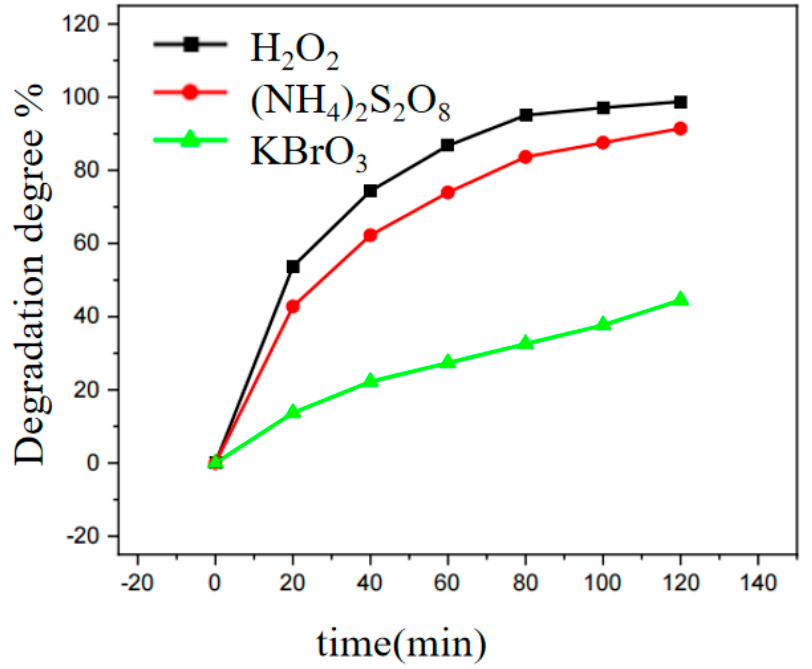
Figure 5. Effect of different electron trapping agents on photocatalytic oxidation of RhB. (Reactor: pH at 4.5, MIL-53(Fe)@CF photocatalytic membrane 150 mg, RhB 1 mg/L, H 2 O 2 1mmol/L). Table 1. Reaction rate constants for different types of electron capture